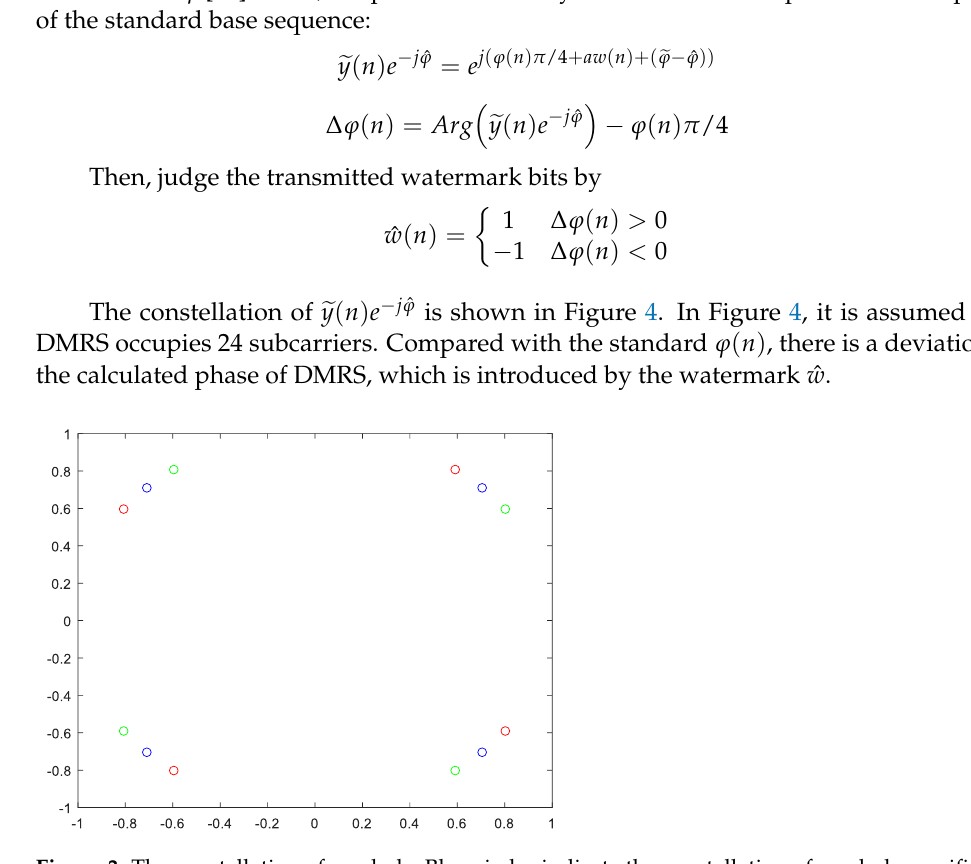
Figure 3. The constellation of symbols. Blue circles indicate the constellation of symbols specified in the protocol, green circles indicate the constellation after embedding bit 0 of the watermark, and red circles indicate the constellation after embedding bit 1 of the watermark.